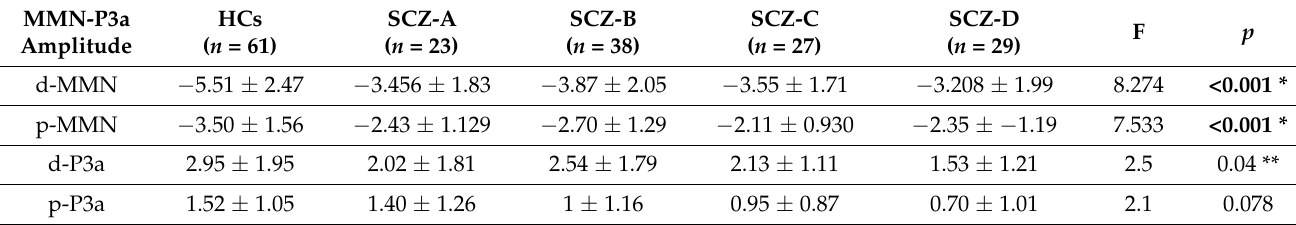
Figure 2. Correlation between p- MMN amplitude and the “work skills” domain of the SLOF scale. p-MMN, pitch deviant mismatch negativity. Negative correlation between p-MMN amplitude and the “work skills” domain of the SLOF scale ( r = −0 .257; p = 0.005) (significant p -value threshold 0.008). This correlation remained significant after controlling for positive, negative, and disorganized symptoms; depression; neurocognition; and global parkinsonism.